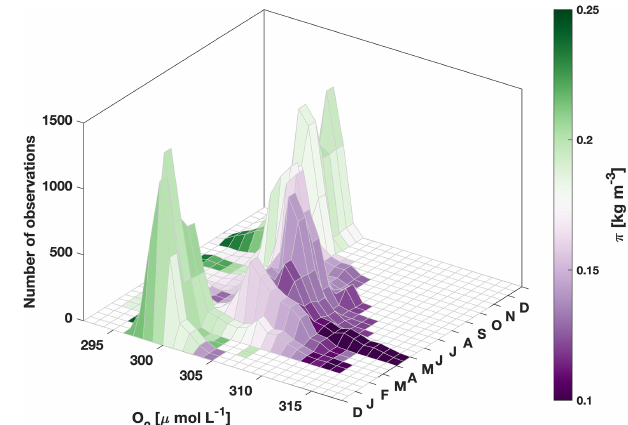
Figure 8. Monthly histogram of oxygen from December 2016 to December 2017 at about 600m depth at K9. Colors show the mean spiciness of each O 2 bin, with lower values corresponding to LSW and higher values to IW (see text for